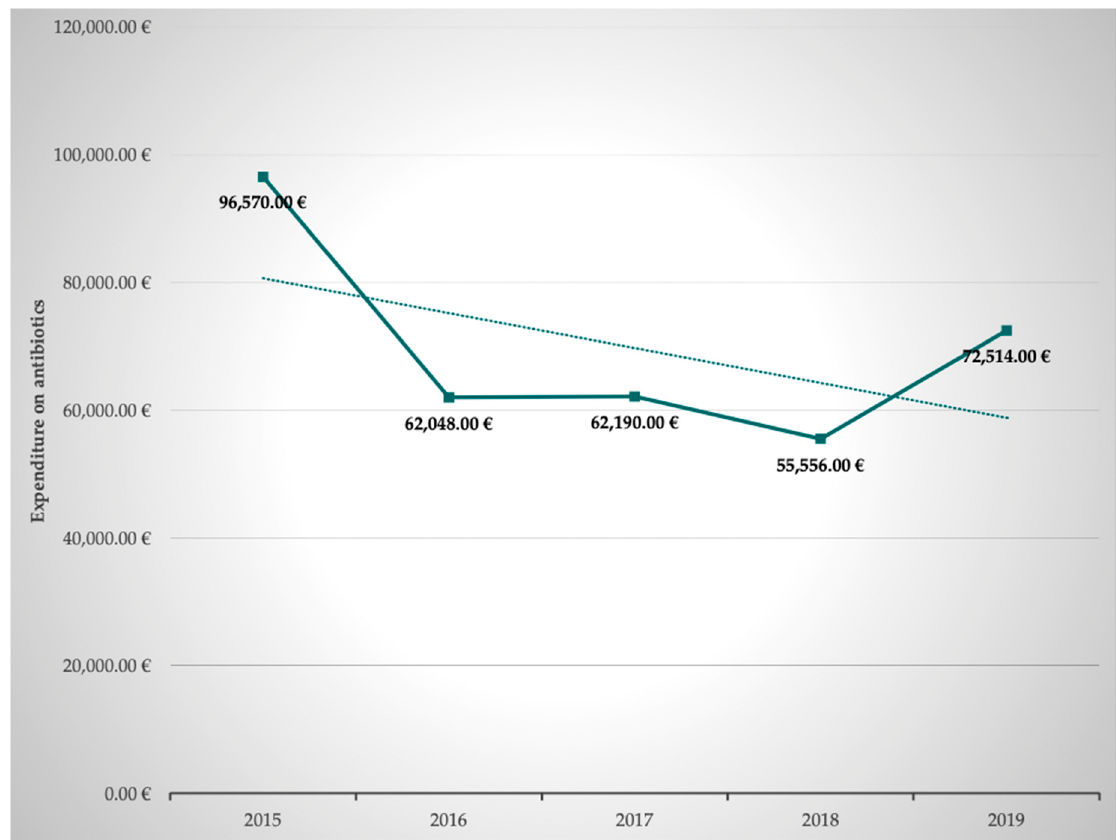
Figure 3. Development of expenditure on antibiotics from 2015 to 2019 in Euro (€) .